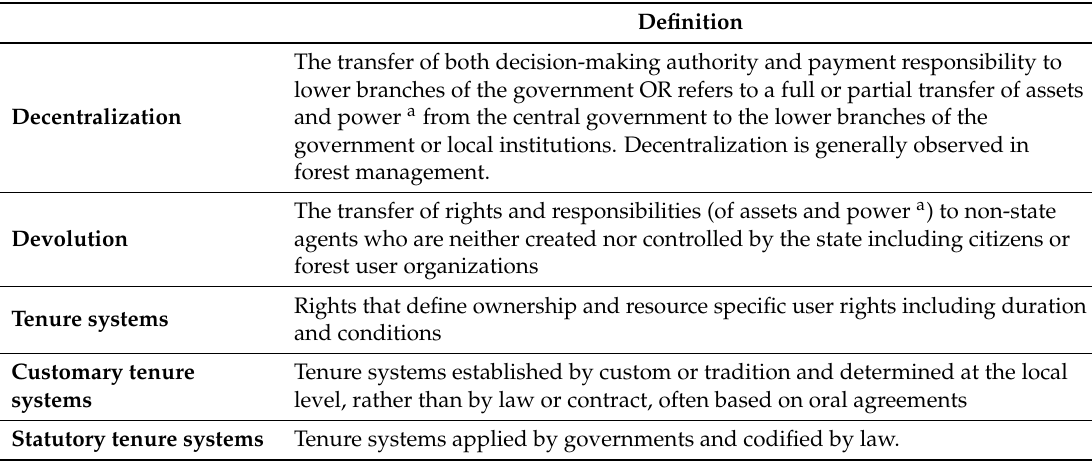
Table 2. Key concepts for community forest